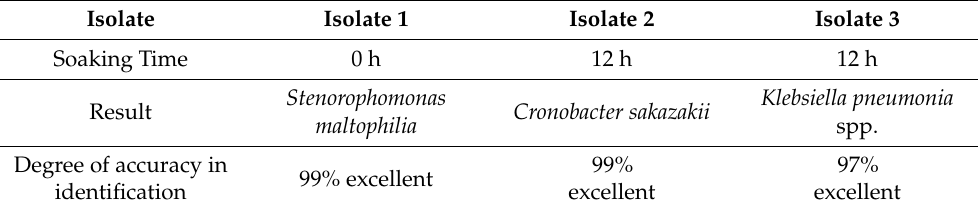
Table 4. Gram-Negative Card Bacterial Identification using Vitek 2.0 system. Isolate Isolate 1 Isolate